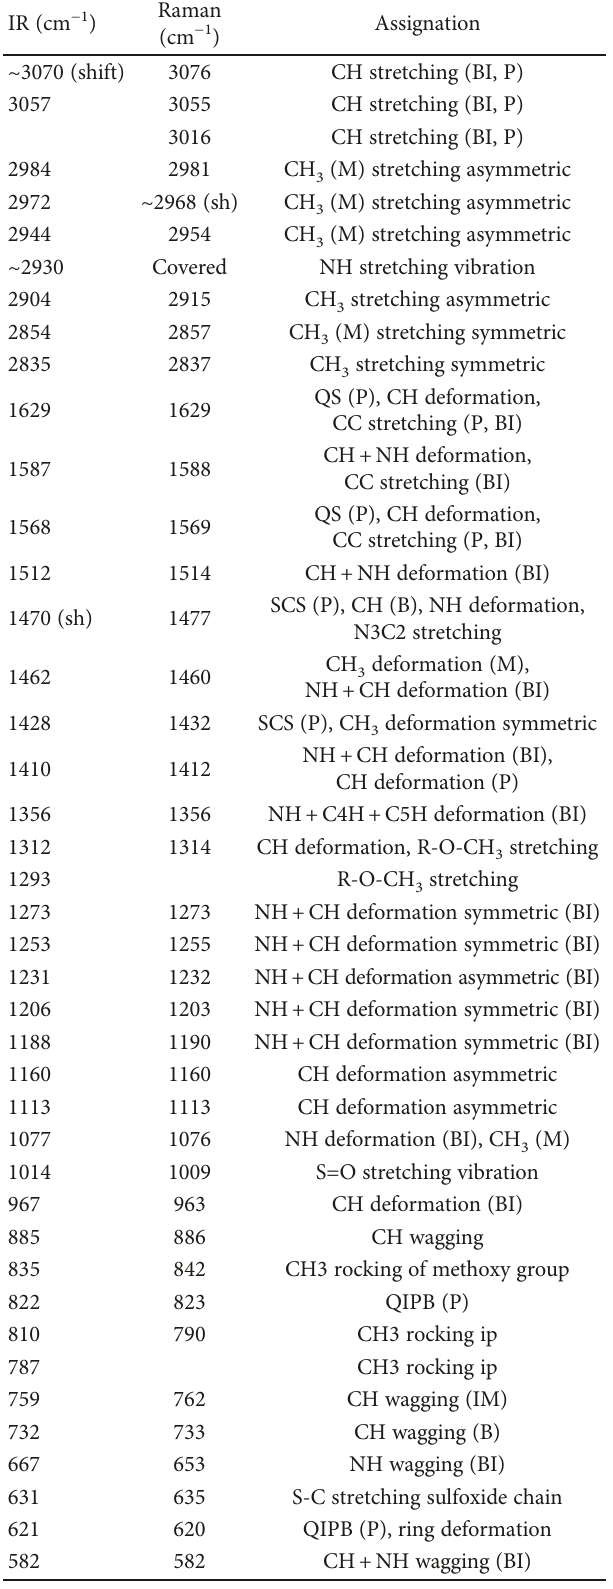
Table 2: Peak frequencies of bands in infrared and Raman spectrum of OMP.